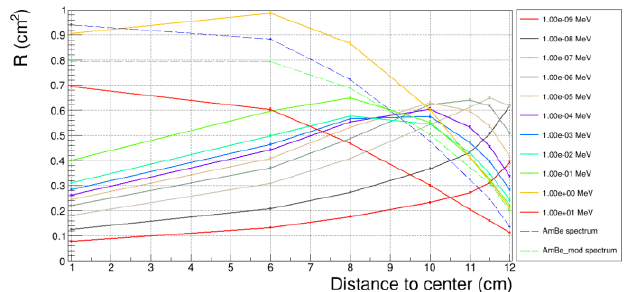
Fig. 4. Response matrix (cm²) of the detectors as function of the distance to the center (cm).